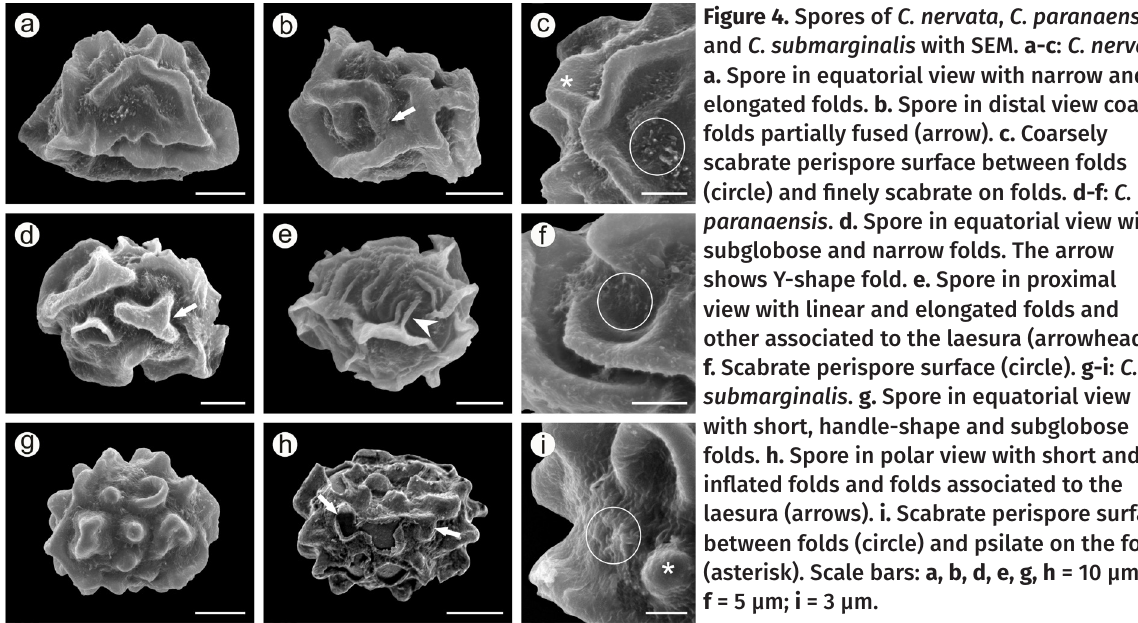
Figure 4. Spores of C. nervata , C. paranaensis and C. submarginalis with SEM. a-c : C. nervata . a. Spore in equatorial view with narrow and elongated folds. b. Spore in distal view coarse folds partially fused (arrow). c. Coarsely scabrate perispore surface between folds (circle) and finely scabrate on folds. d-f : C. paranaensis . d. Spore in equatorial view with subglobose and narrow folds. The arrow shows Y-shape fold. e. Spore in proximal view with linear and elongated folds and other associated to the laesura (arrowhead). f. Scabrate perispore surface (circle). g-i : C. submarginalis . g. Spore in equatorial view with short, handle-shape and subglobose folds. h. Spore in polar view with short and inflated folds and folds associated to the laesura (arrows). i. Scabrate perispore surface between folds (circle) and psilate on the folds (asterisk). Scale bars: a, b, d, e, g, h = 10 µm; c, f = 5 µm; i = 3